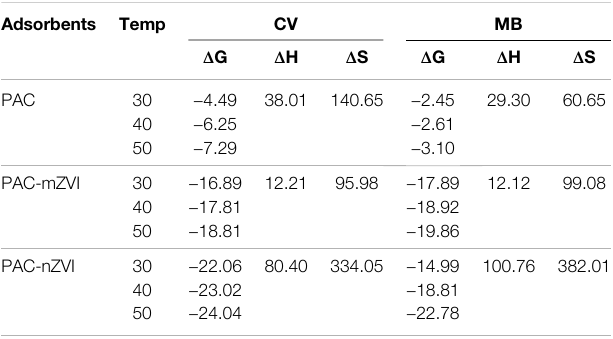
TABLE 5 | Thermodynamic parameters for the adsorption of CV and MB on PAC and PAC-based ZVI adsorbents. Adsorbents